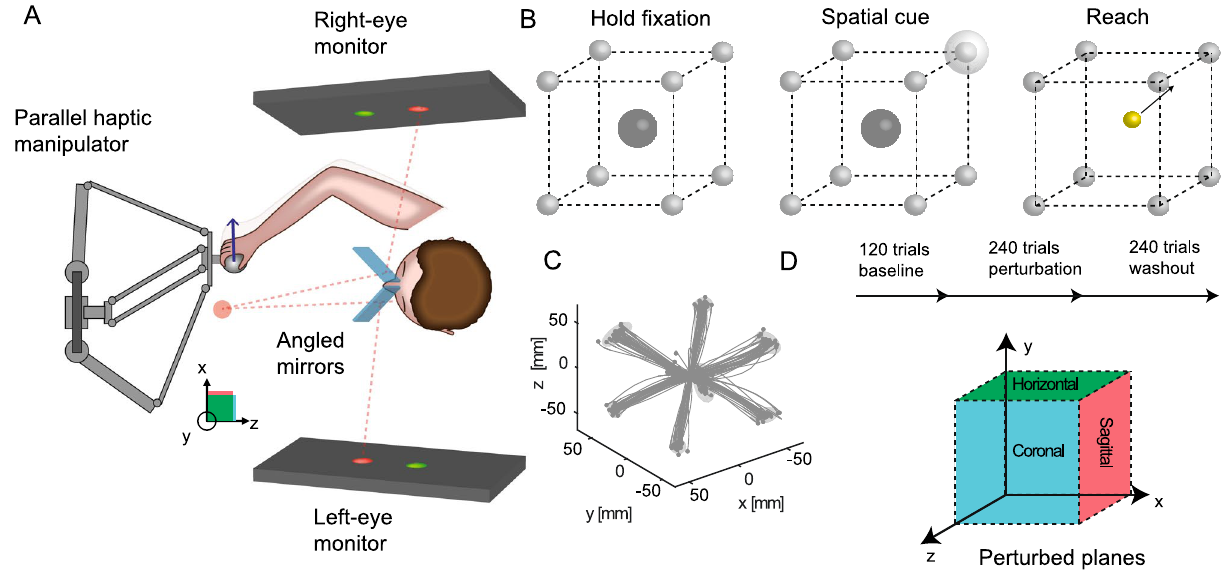
Figure 1. Virtual reality setup with robotic manipulator for testing visuomotor rotation adaptation of naturalistic reaches in different planes relative to the body. ( A ) Schematic representation of the 3D virtual reality setup. The two angled mirrors reflect the image from the two screens to the two eyes independently providing stereoscopic vision. The mirrors are semitransparent to allow calibration of the virtual reality space with the real hand position. During the experiments, transparency is blocked, so that the subjects do not see the robotic manipulator and their hand, but only the co-registered cursor. ( B ) Spatial and temporal structure of the 3D reaching task. Following a brief holding period in the center of a virtual cube, the subject has to reach to one of eight targets arranged at the corners of the cube. For ergonomic reasons, the cube is orientated relatively to the slightly downward-tilted workspace and head of the subject, not according to true horizontal. ( C ) Example baseline trajectories of a single subject. ( D ) Time course of the perturbation experiment. Following a baseline phase of 120 trials, a 30-degree visuomotor perturbation is applied for 240 trials, followed by a washout of 240 additional trials. In three separate blocks for each subject, the perturbation is applied in the sagittal, coronal and horizontal plane, respectively. Note that all reaches are conducted along a diagonal direction, i.e., each movement is affected by either of the